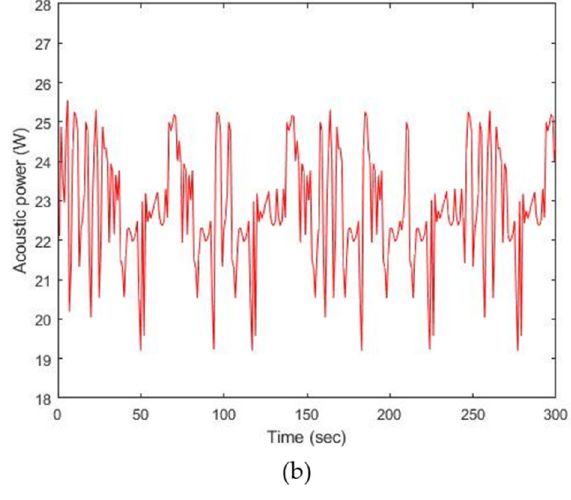
Figure 11. Results of acoustic power emission: ( a ) 200 V pp , ( b ) 300 V pp. P avg values and their corresponding TIs are represented as a function of voltage amplitude in Figure 12. P avg from the transducer loaded by 150 V pp amplitude is 9.2 W, and the corresponding TI is 1.6. For 250 V pp stimulation, those values are 20.2 W and 3.6. The